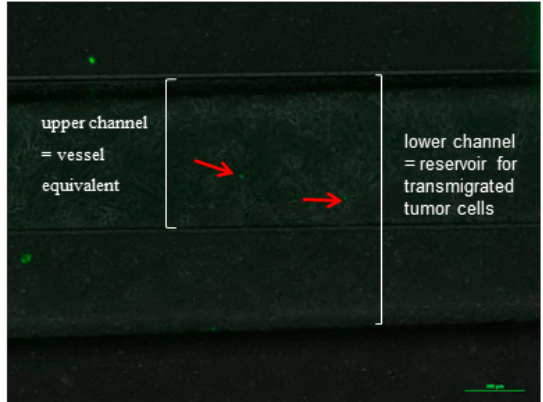
Figure 6. Example of an image of the microfluidic channel with endothelial lining (HPAEC) and adherent tumor cells (H838GFP) during an experiment, after a flow time of 60 min at a flow velocity of 24 mm/s. Endothelial cells were incubated with medium for 30 min before tumor cells were introduced into the microfluidic system.